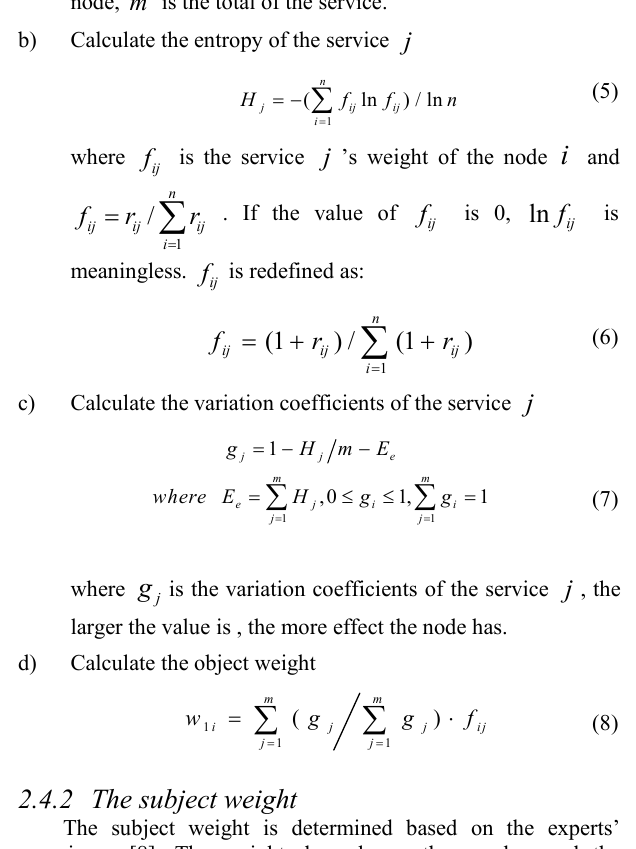
Figure 2: The flowchart of